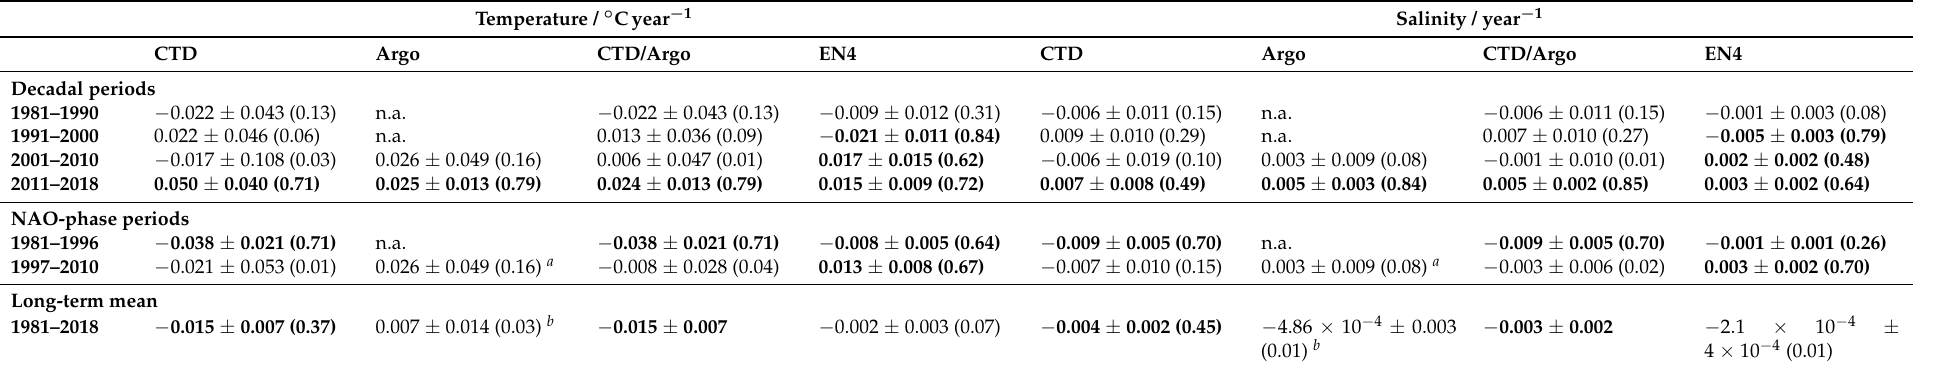
Table 1. Estimated temperature and salinity trends and confidence intervals between 1981 and 2018, calculated for the study domain in Figure 1a. The trends were determined using only CTD data, Argo floats, combined (CTD/Argo) dataset, and EN4 dataset. Trends were calculated for each decade, and also according to NAO-phase periods. The NAO periods are divided as follows: 1981–1996 corresponds to a predominantly positive NAO; 1997–2010 comprises a period of transition from a strongly negative NAO phase (in 1996) to neutral values in the following years; and 2011–2018 corresponds to a transition of a strongly negative NAO in 2010 to a positive phase afterwards. Once the last period coincides with the last decade, the values are not repeated. Trends significant at 95% confidence level are in bold. The variance explained by the least-square linear trend (r 2 ) is presented in brackets. n.a. = not